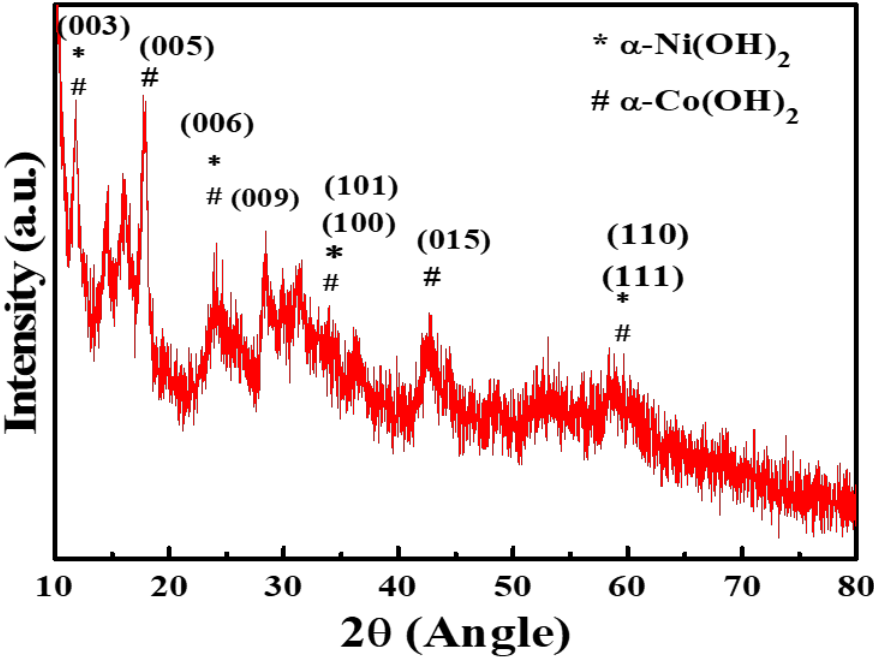
Figure 1. XRD pattern of NiCo(OH) 2 -LDH. The peaks for NiCo(OH) 2 appear at 2 θ values between 11 and 60. The detectable diffraction peaks of NiCo(OH) 2 are in good agreement with those reported previously and can be referenced to α -Ni(OH) 2 and α -Co(OH) 2 , matching JCPDS No: 38-0715 and JCPDS No: 01-087-0645 [30,31], respectively. The XRD pattern, which typically shows a steep